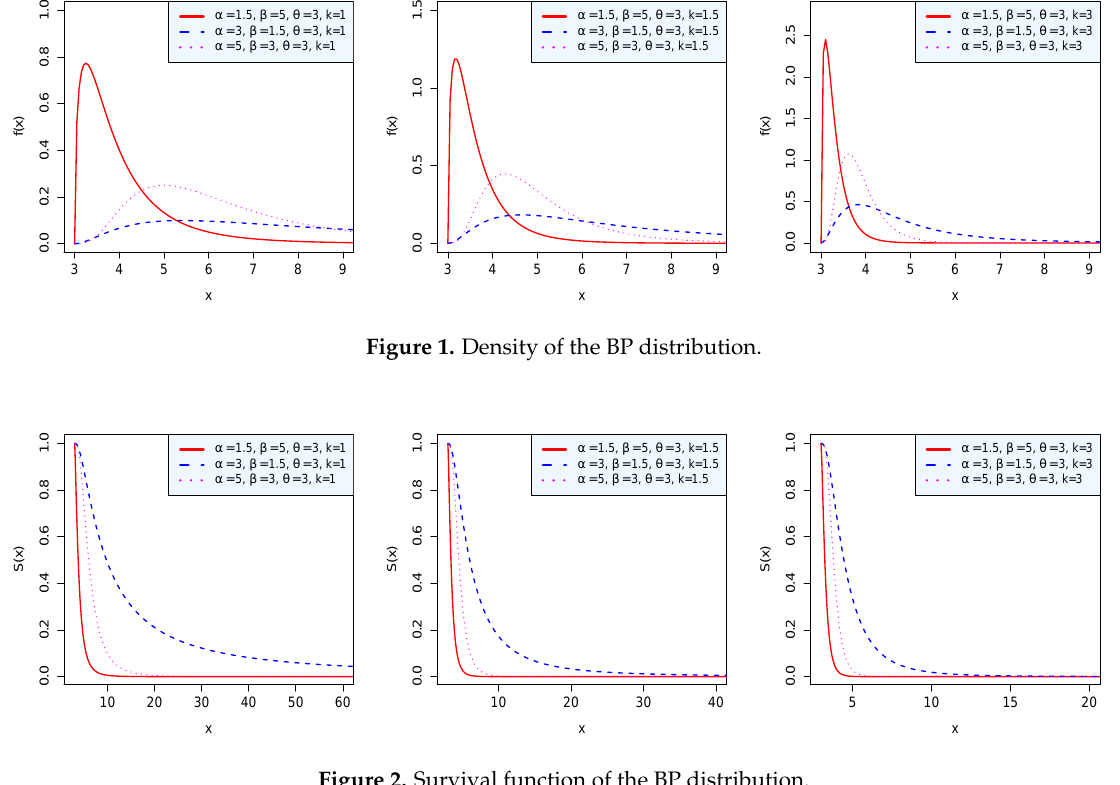
Figure 2. Survival function of the BP distribution.